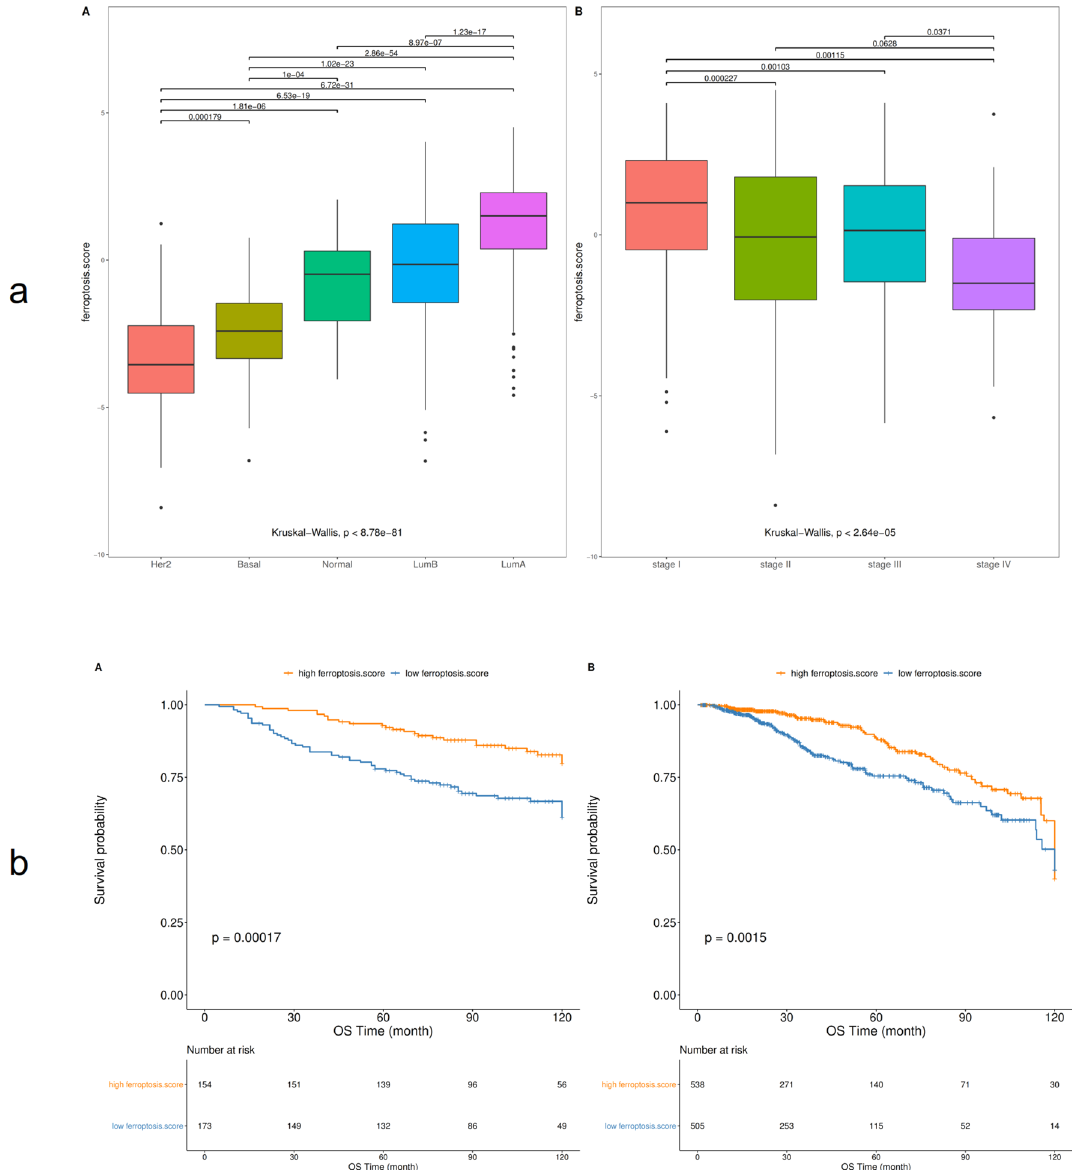
Figure 10. Relationship between ferroptosis scores with other datasets and prognosis. ( a ) Comparative analysis of ferroptosis scores in different PAM50 molecular classifications and clinical characteristics (A: PAM molecular classification, B: clinical stage); ( b ) Kaplan–Meier survival curve (A: GSE20685, B: